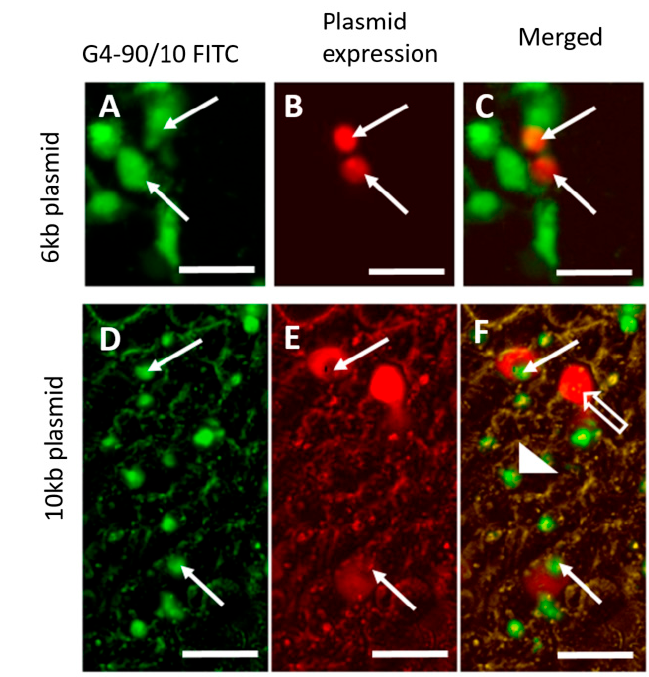
Figure 9. Images ( A ) and ( D ) show that the dendriplexes formed with G4-90/10-FITC and RP1 are taken up by the HEK293 cells; images ( B ) and ( E ) show mCherry expression from RP1 and RP2; and images ( C ) and ( F ) (solid arrow) show colocalization between the G4-90/10-FITC and the mCherry. The open arrow and the arrowhead in image F show mCherry expression but exocytosed G4-90/10- FITC and G4-90/10-FITC delivery before mCherry is expressed, respectively (Scale bar: 100 µm).